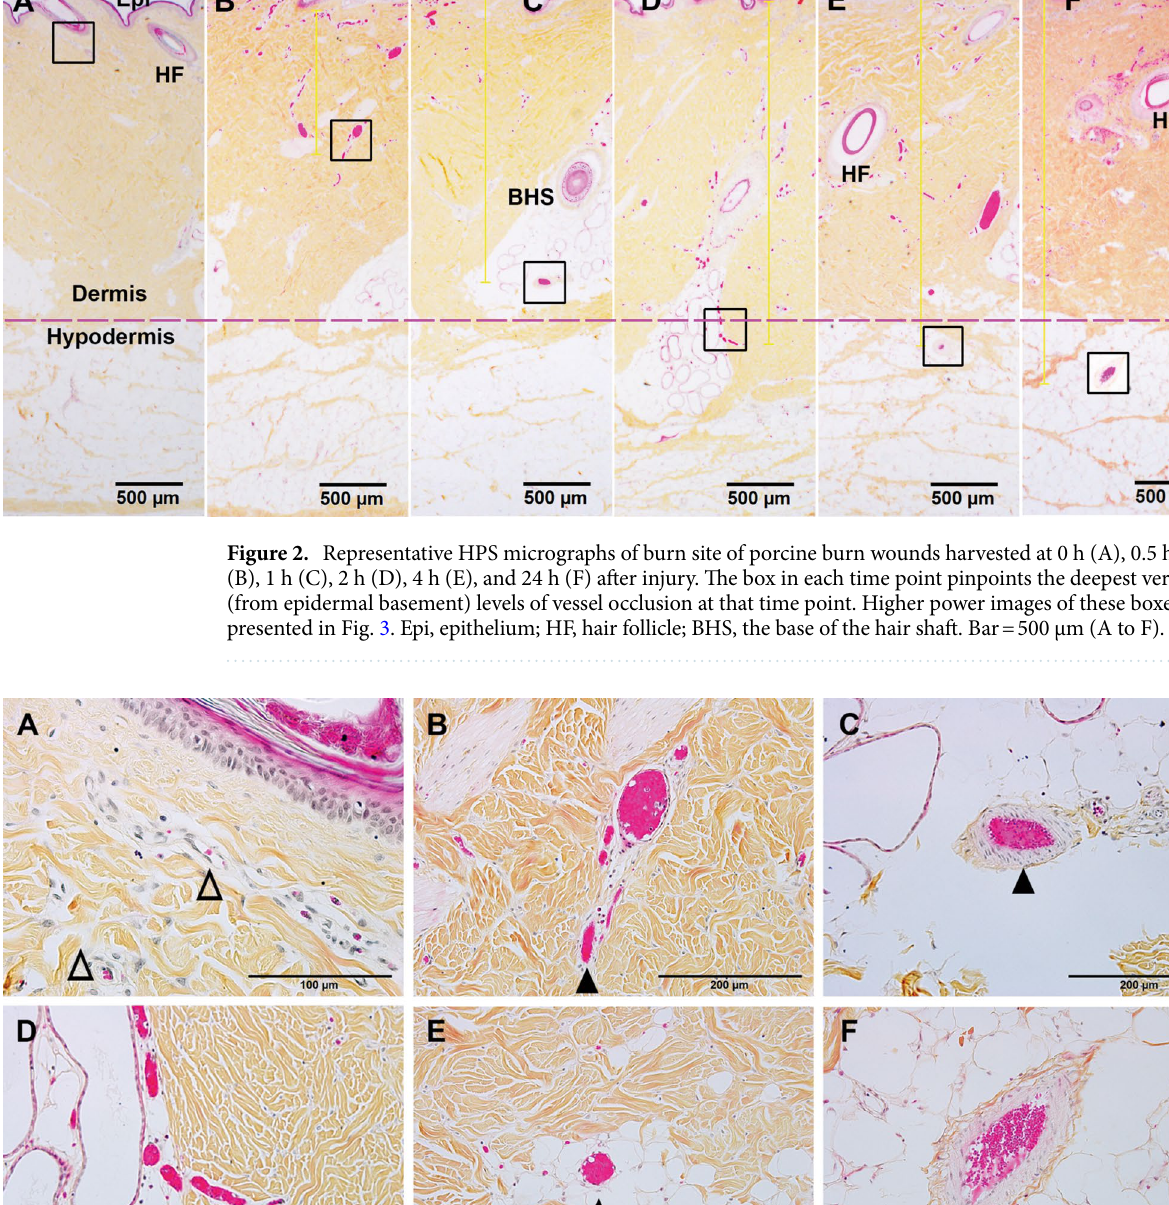
Fig. 3 further confirmed the presence of clear small blood vessels (∆) beneath the epidermis at 0 h (control), and